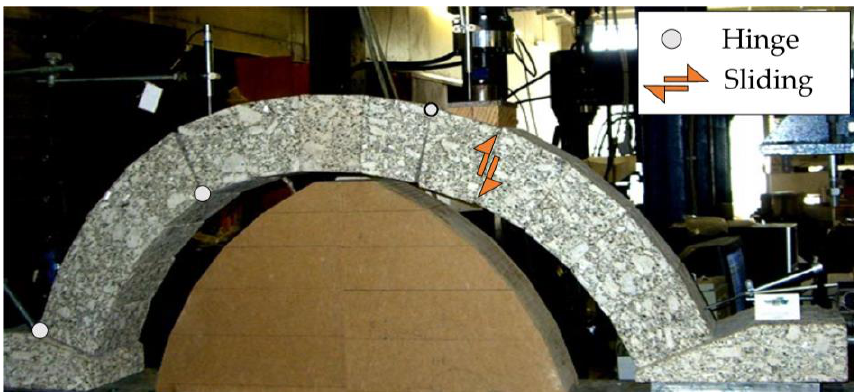
Figure 4. Deformed shape of the arch at the ultimate displacement, retrieved from [35].